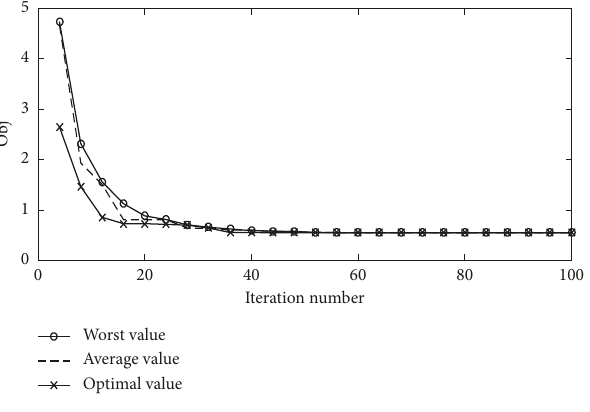
Figure 7: Iterative